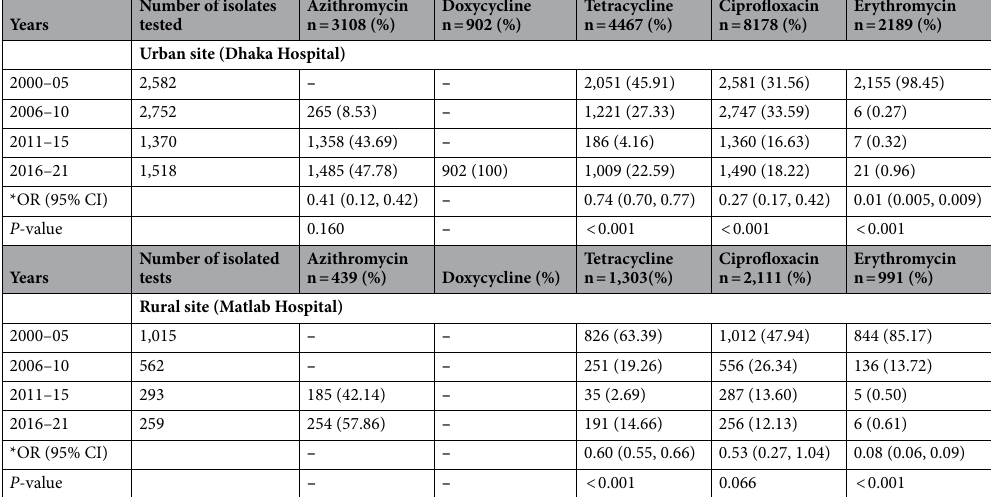
Table 2. The Percentage of V. cholerae susceptible to tetracycline, erythromycin, ciprofloxacin, doxycycline, and azithromycin during the period, 2000–2021 (urban Dhaka and rural Matlab sites). OR odds ratio; “ – “: susceptibility pattern not checked for the antibiotics.